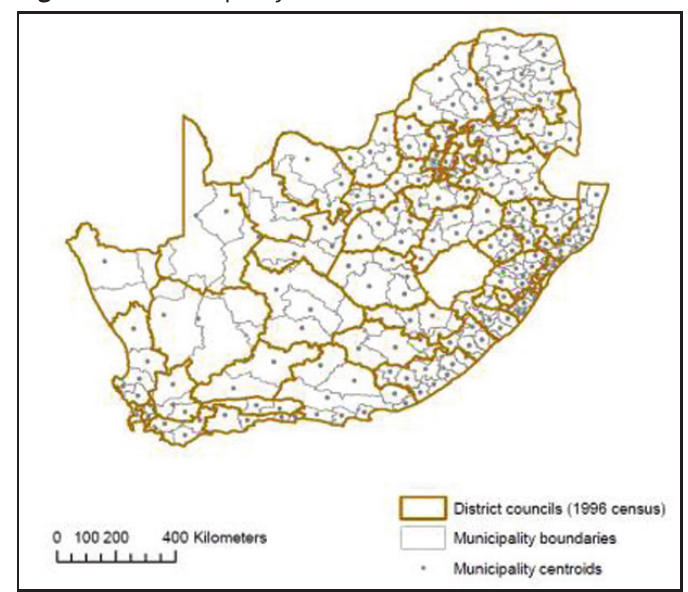
Figure B2 Municipality and the 1996 district council boundaries.